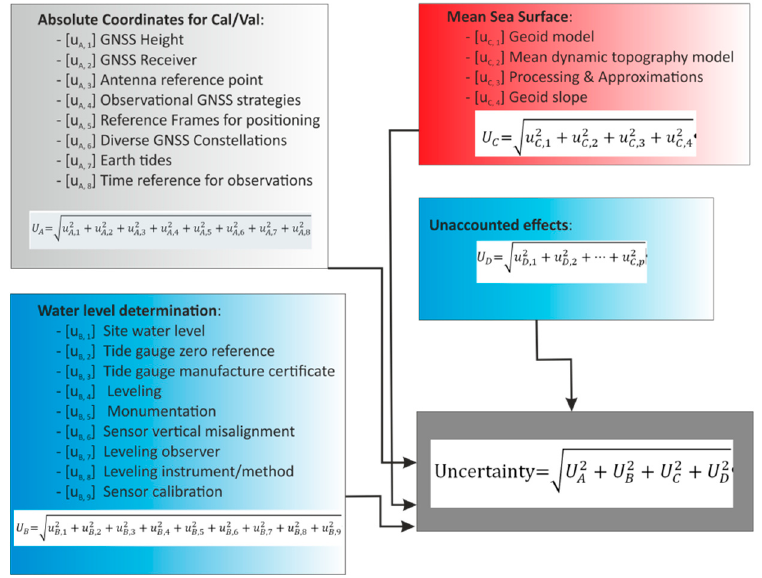
Figure 8. The above diagram shows an example on how to characterize uncertainty budgets in altimetry calibration with sea-surface techniques after analyzing all the error constituents contributing in the